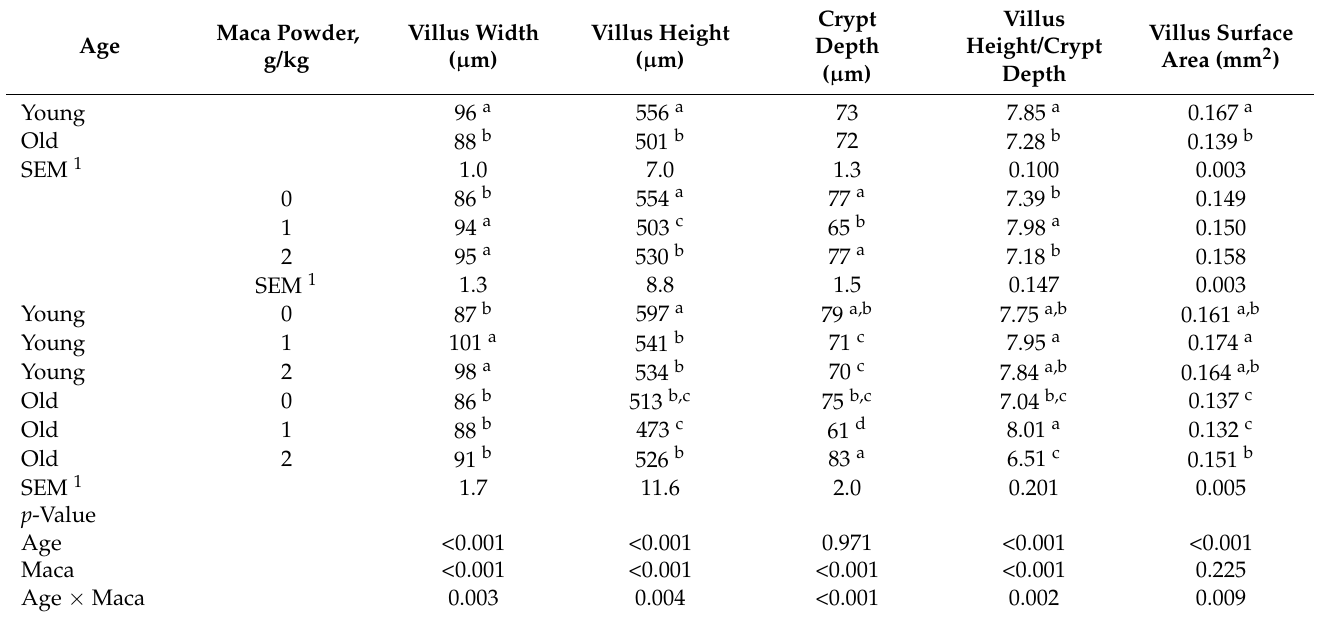
Table 6. Effects of Maca powder supplementation in diets of laying quails at different ages on ileum histomorphological